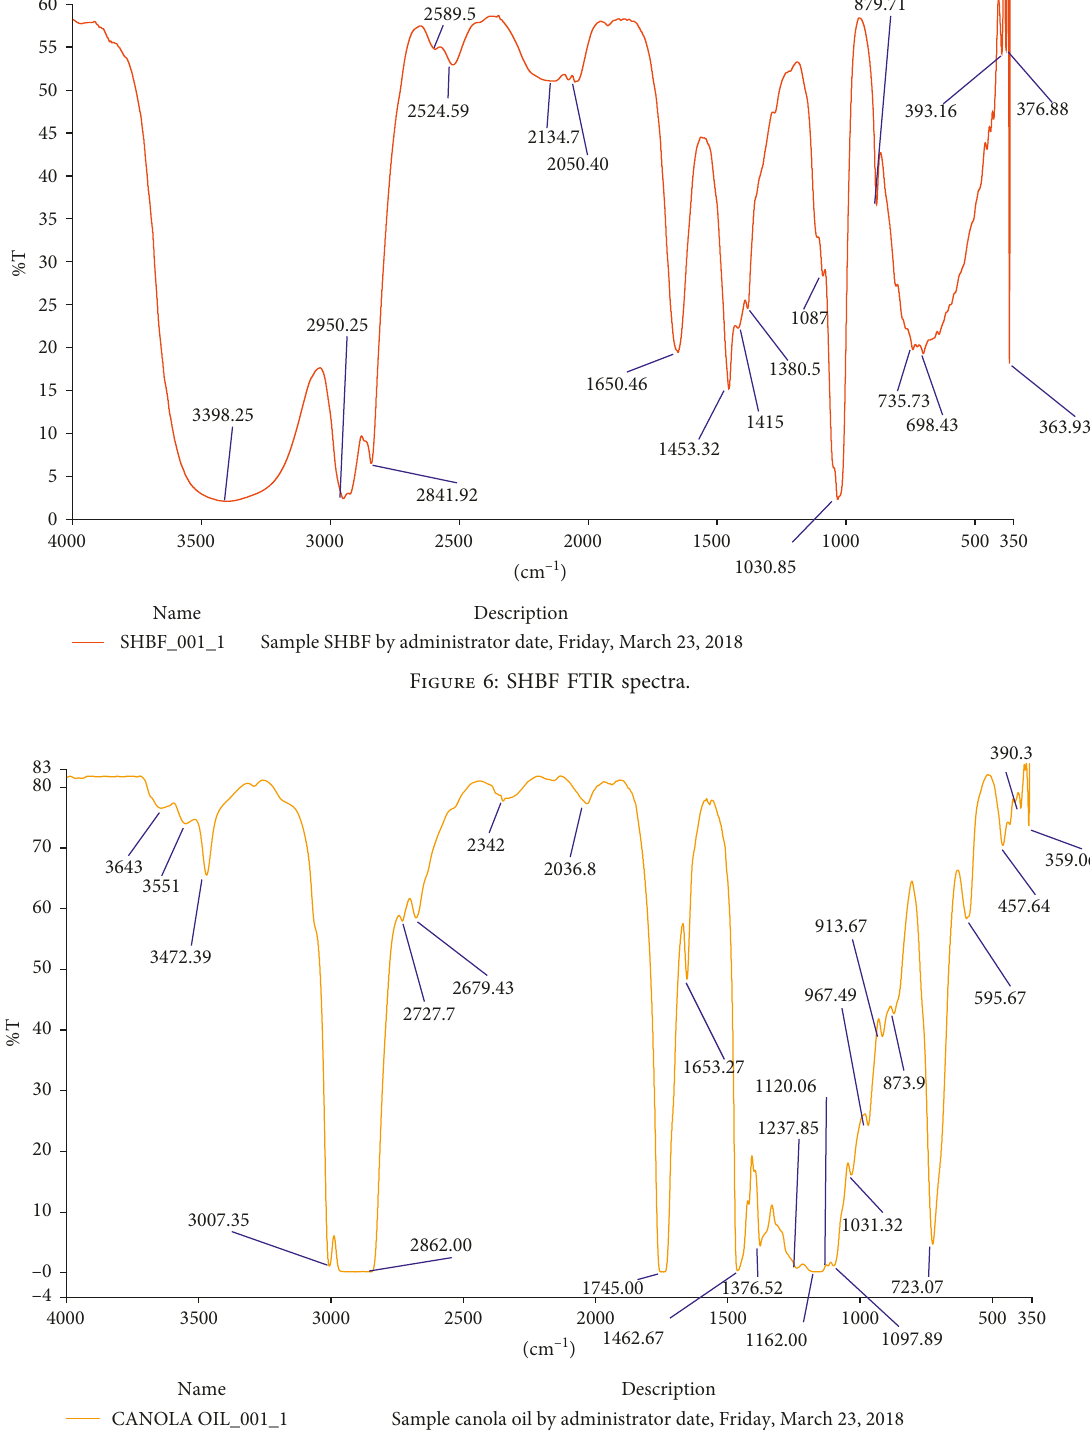
Figure 7: Canola oil FTIR